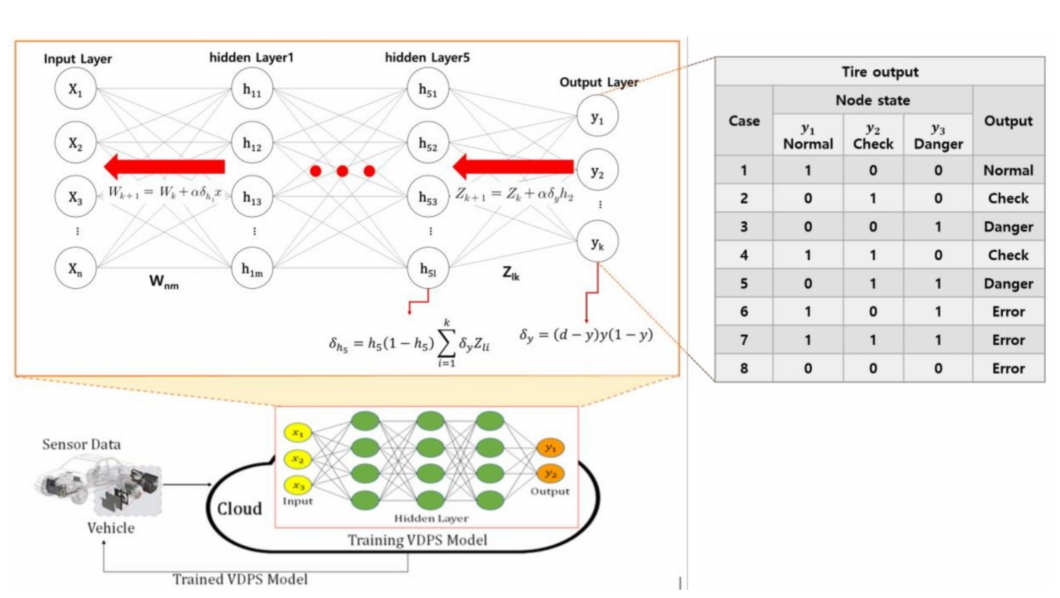
Figure 7. The structure of the Vehicle Part Diagnosis Sub-module